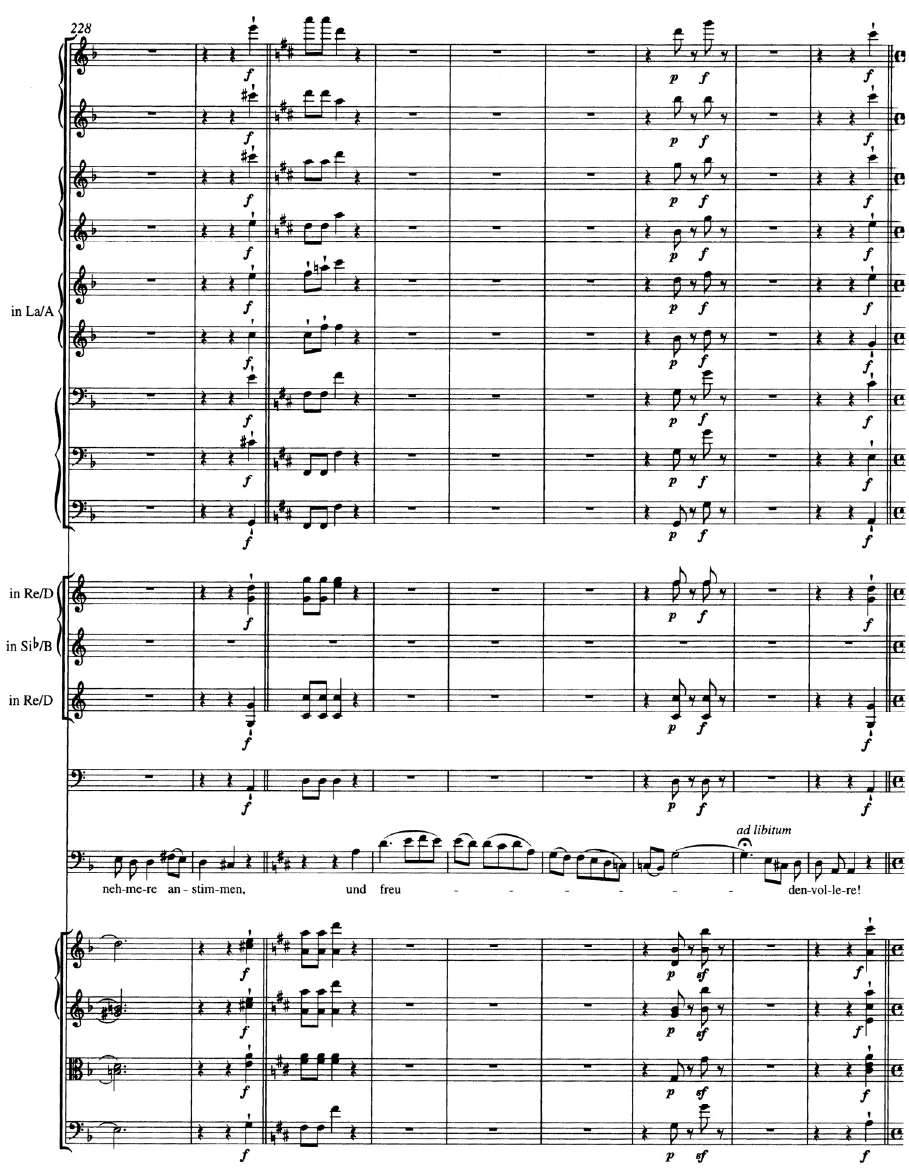
Figure 3. Ludwig van Beethoven, Symphony No. 9 in D Minor, Op. 125, Finale. Urtext edited by Jonathan Del Mar, Kassel: © 1999, Bärenreiter-Verlag. Finale, Recitativo, mm. 228–236. Used with permission of Bärenreiter-Verlag , Kassel